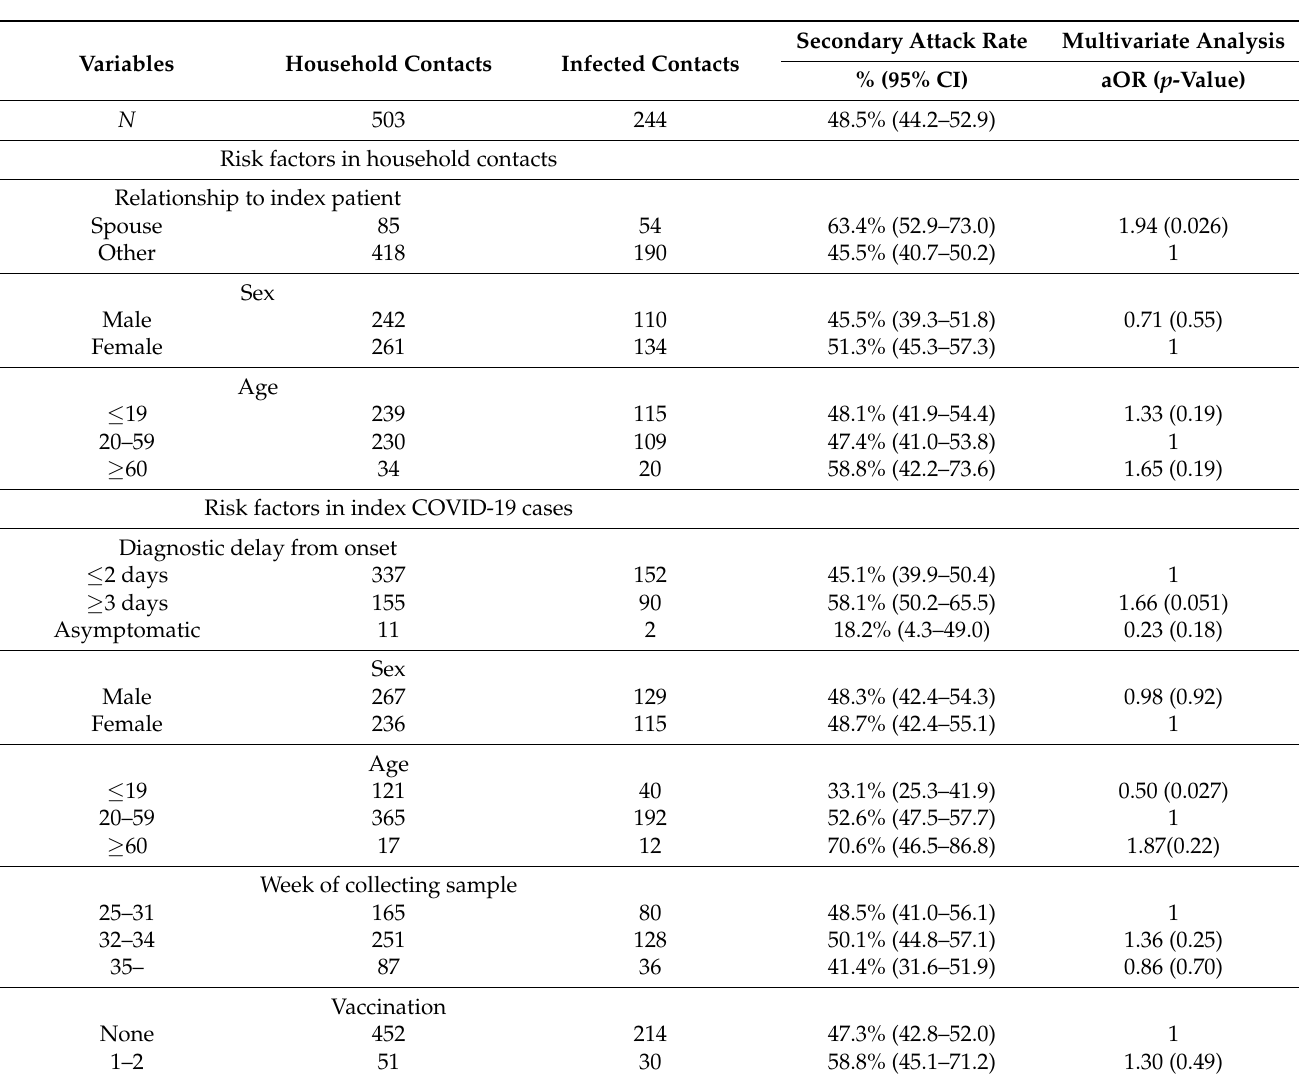
Table 4. Secondary attack rate among unvaccinated household contacts of COVID-19 patients with Delta